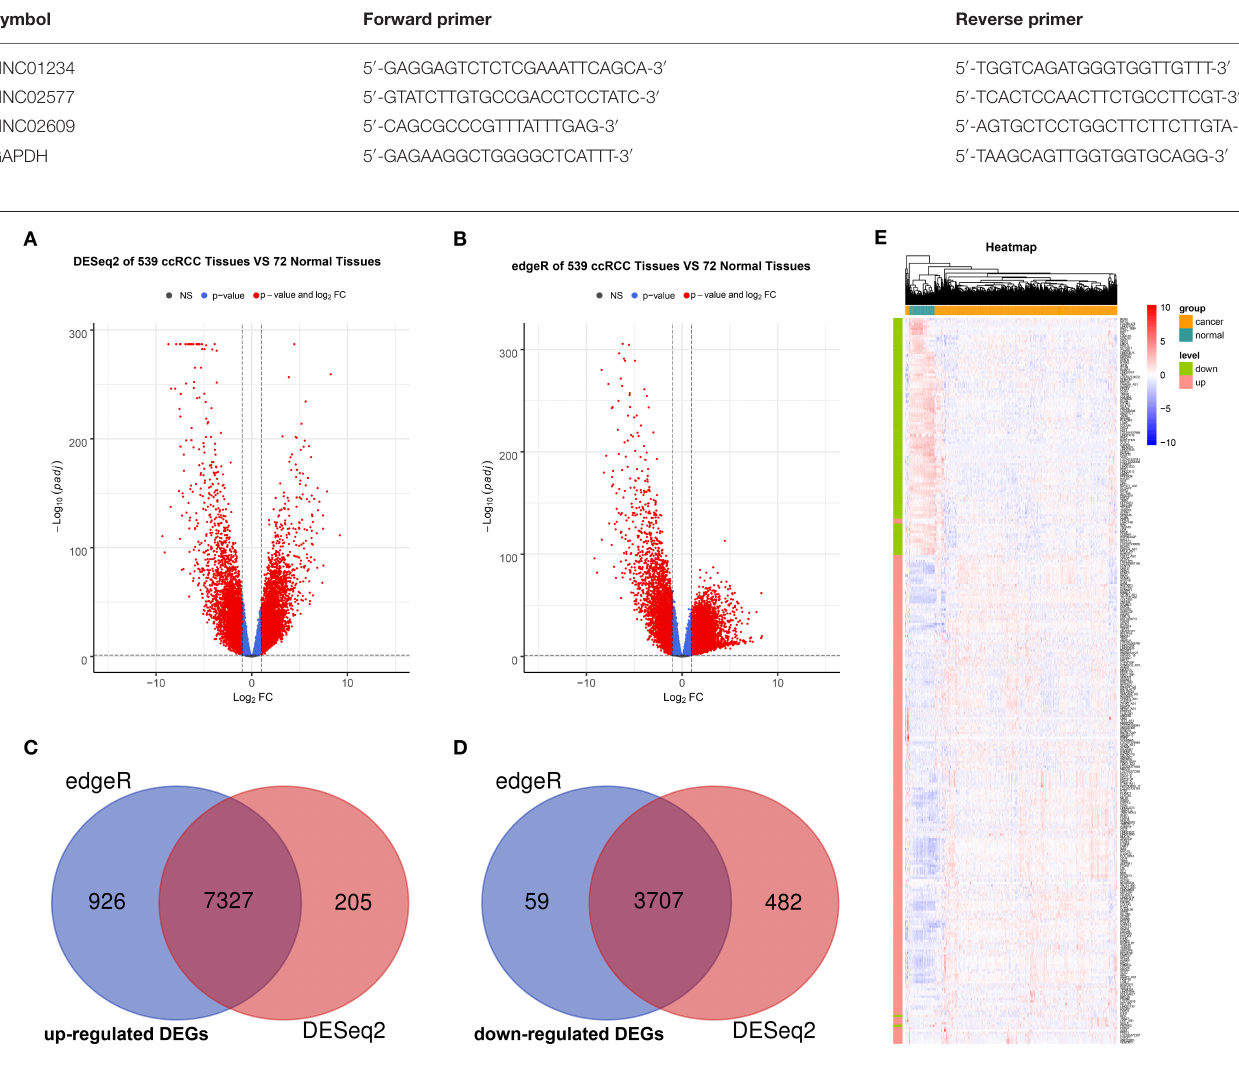
FIGURE 2 | Identification and validation of DEGs. Volcano maps of DEGs screened by “DeSeq2” package (A) and “edgeR” package (B) . The red nodes represent DEGs. The cutoff values are log|FC| > 1 and the adjusted p < 0.05. Venn diagram of common upregulated DEGs (C) and common downregulated DEGs (D) in 2 R packages. (E) Heatmap based on DEGs between 539 ccRCC tissues and 72 normal tissues. Each row represents a screened DEG, in which green bar represents downregulated DEGs and red bar represents upregulated DEGs. Each column represents a tissue sample, where blue bar represents normal tissues and orange bar represents ccRCC tissues. In the heatmap, blue represents negative correlation, while red represents positive correlation. DEGs, differentially expressed genes; ccRCC, clear cell renal cell